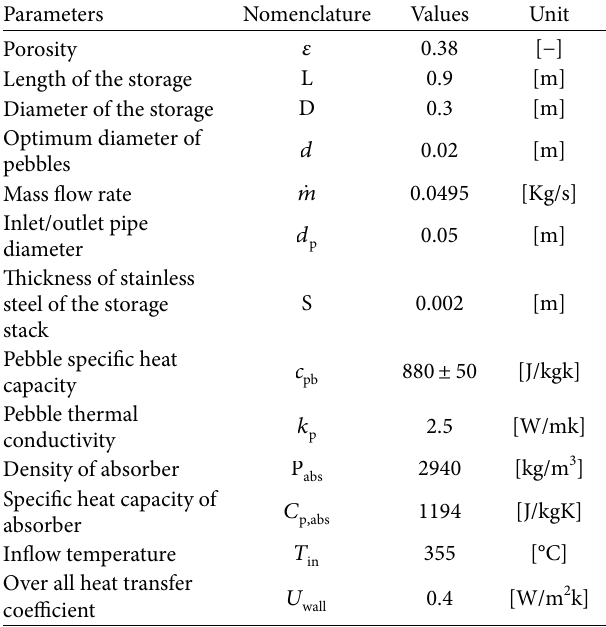
Table 2: Bench mark experimental data [9] and calculated